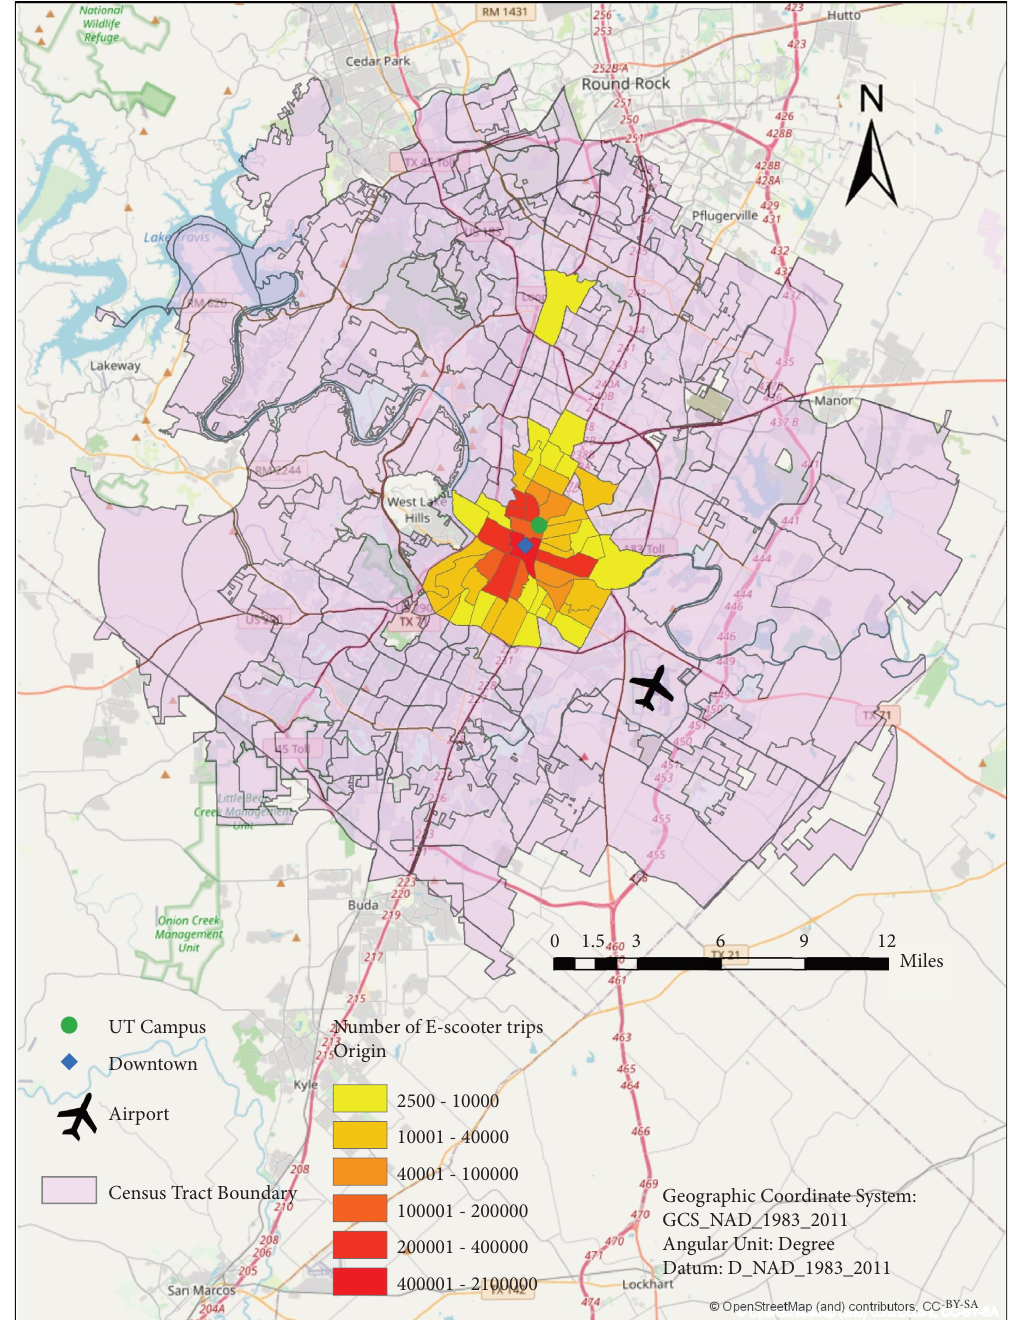
Figure 1: Total number of e-scooter trips in thousand in Austin at the census tract level for the year 2019 (data source: city of Austin open data